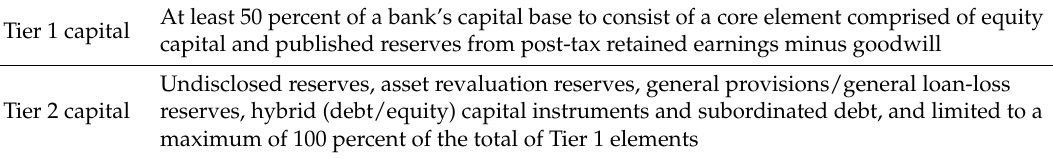
Table 2. Components of Total